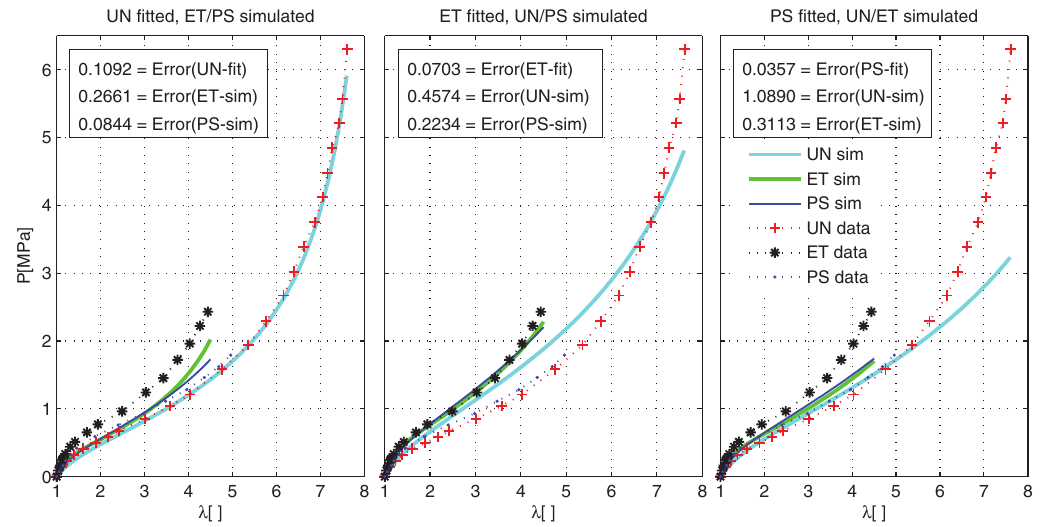
Figure 7: Performance of the Bechir model on the Treloar